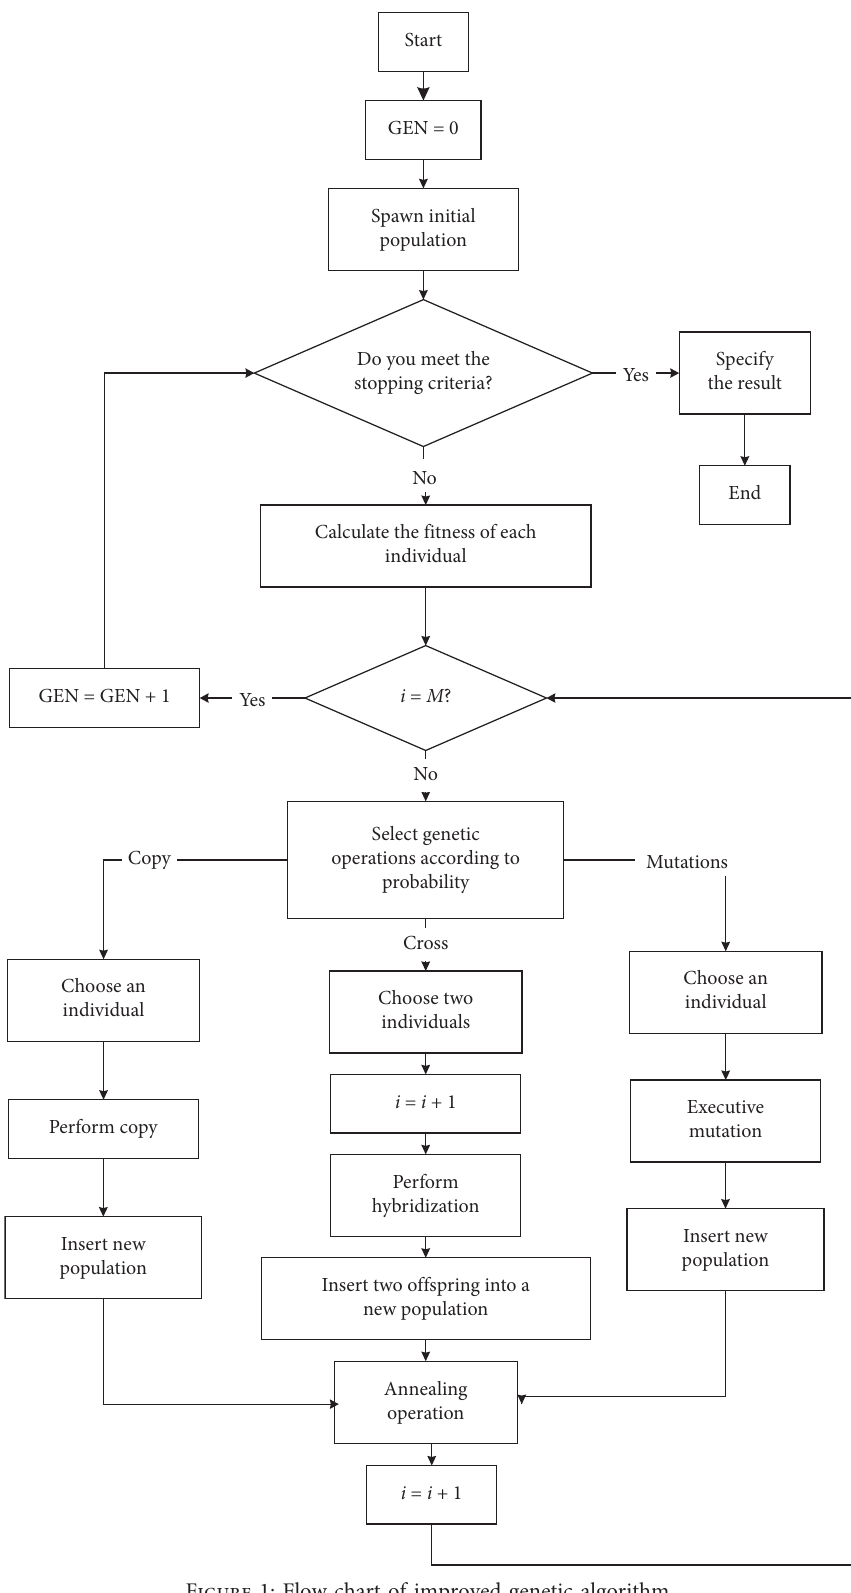
Figure 1: Flow chart of improved genetic